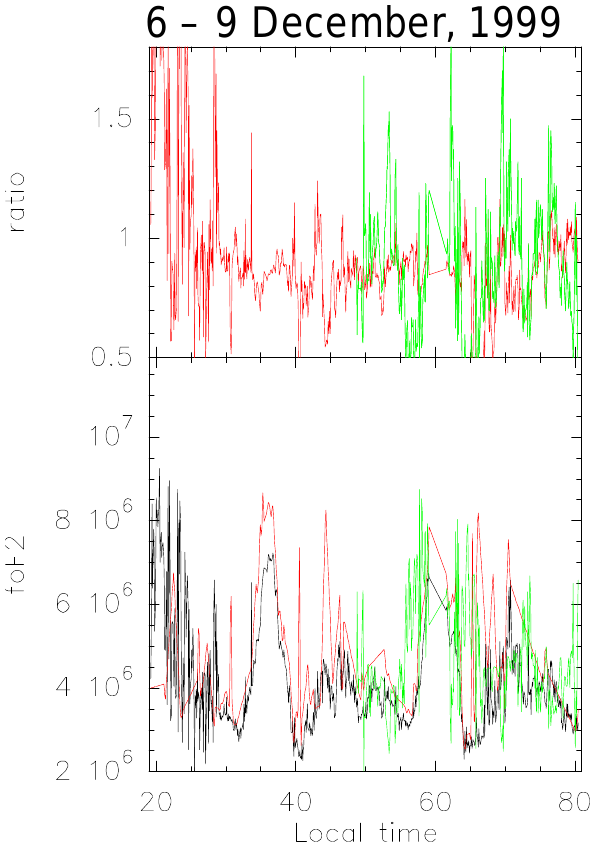
Fig. 4. fo F2 comparison between the IS radar data in black and the IS-ionosonde in red. In the upper panel, the full line shows the points that have been kept to compute the mean